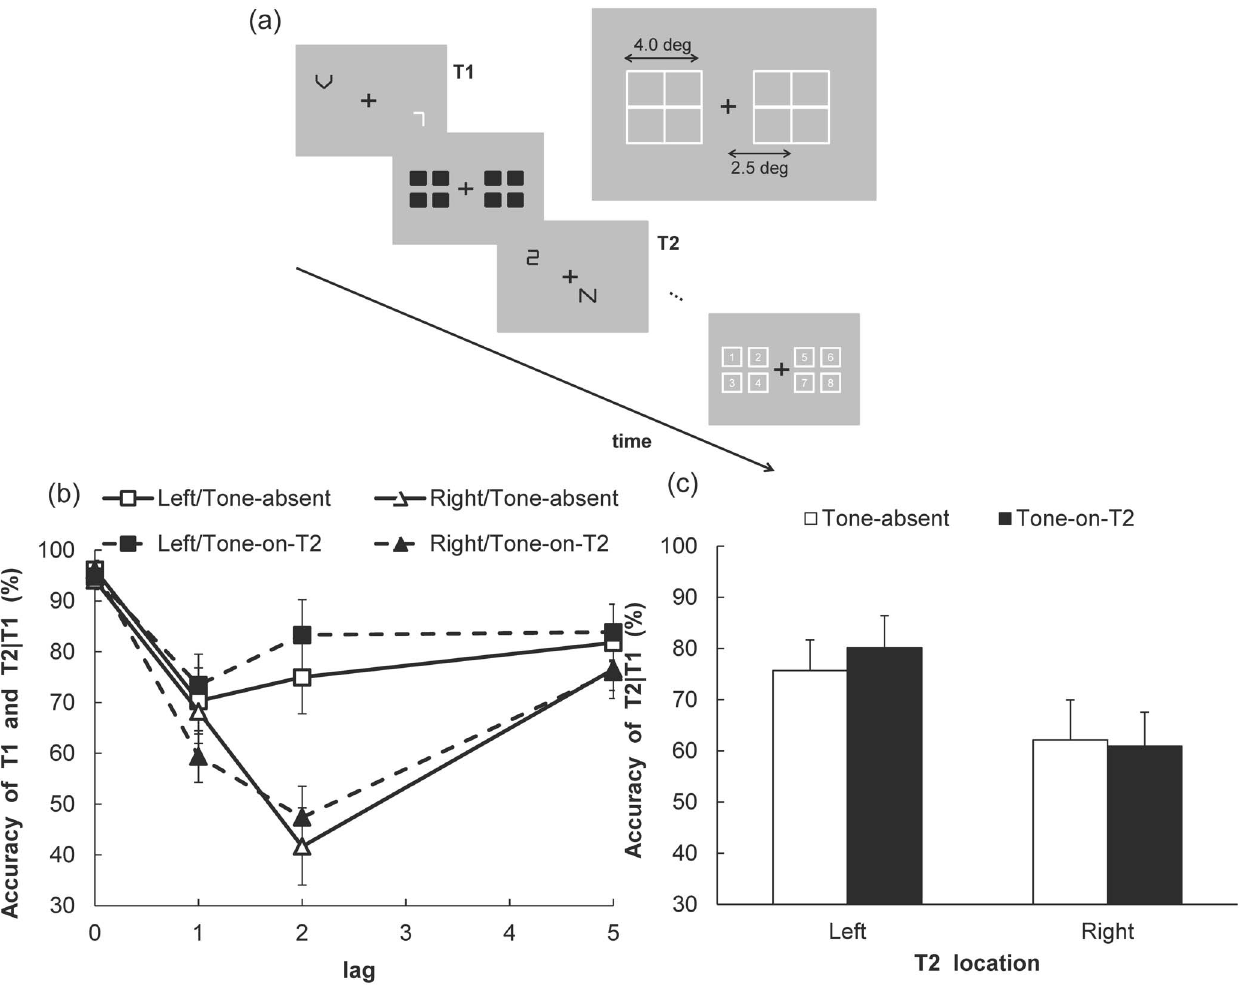
Figure 5. Outline of the paradigm and T1 and T2 localization performance in Experiment 3. (a) Trial sequence: Participants were presented with two RSVP streams and were instructed to determine the location of the two digit targets among a series of letters. The visual stimuli were presented randomly at one of the four locations on both the left and right sides on the display. T2 was presented at lag-1, lag-2, or lag-5, after T1. A tone was presented simultaneously with the onset of T2. (b) T1 accuracy and T2 accuracy (given that T1 is correct) in each of the Tone, Visual field, and Lag conditions. (c) T2 accuracy (given that T1 is correct) in each of the Tone and T2 visual field conditions. Vertical axes indicate the T2 accuracy (percent correct). Error bars represent standard errors of the mean ( n =8: With the permission from JPS, reprinted with partially modified from Takeshima and Gyoba [60]).